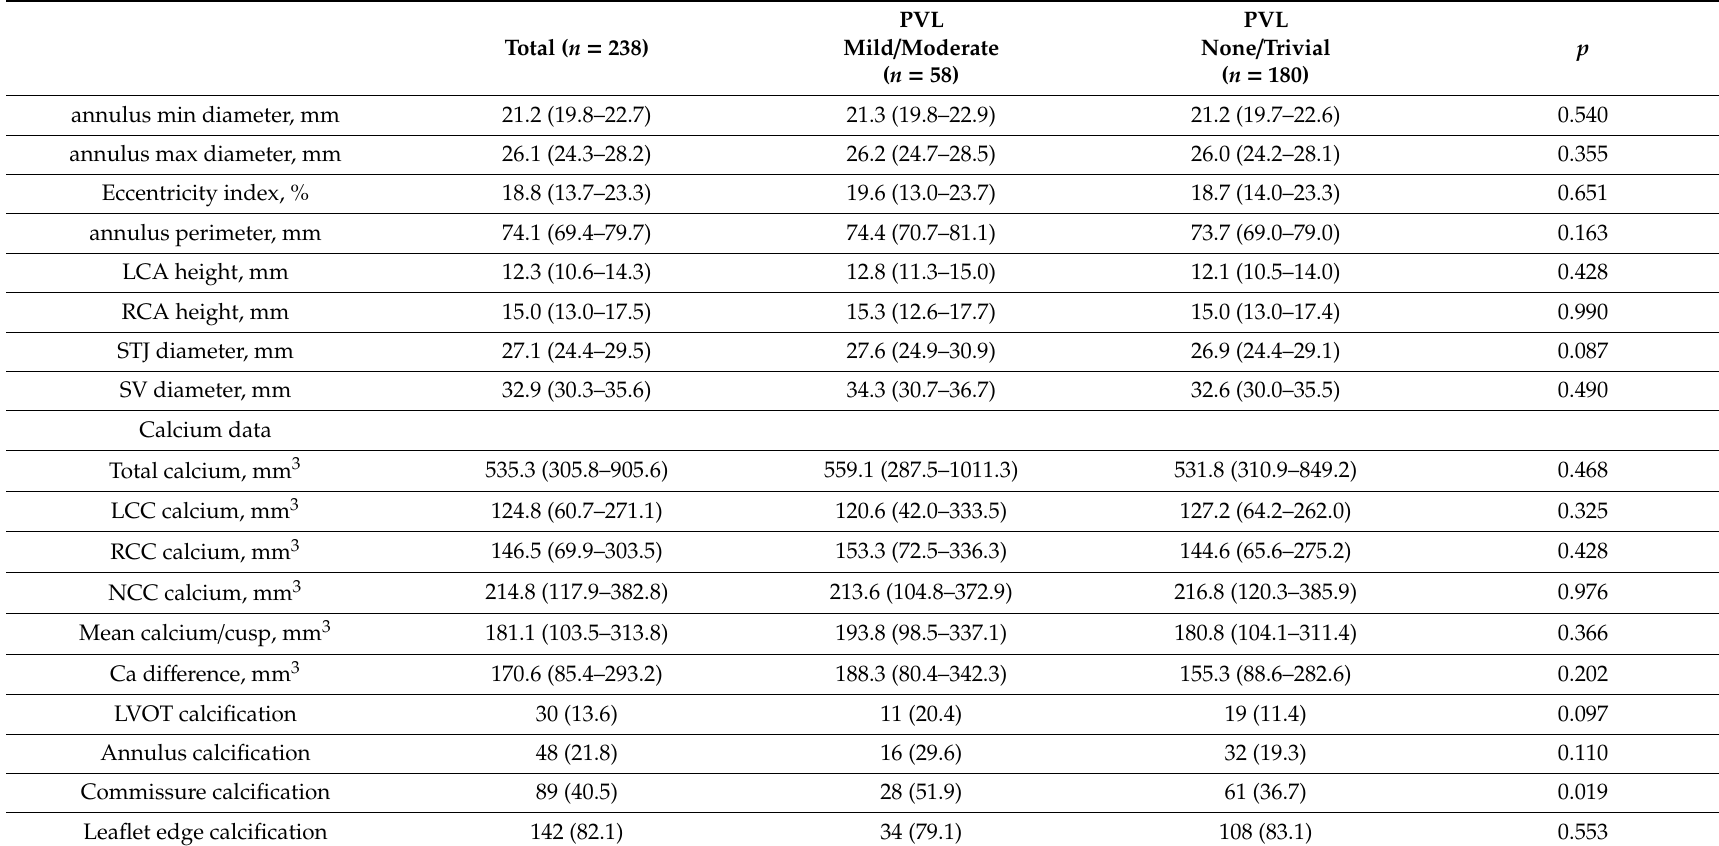
Table 2. Baseline computed tomography. Characteristics according to presence or absence of